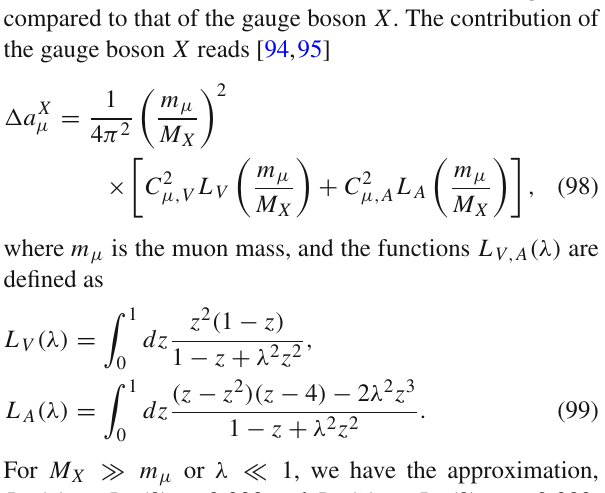
which is at 4 . 3 σ . In this model, the new contributions to the Table 2 The Z (cid:7) couplings to the SM fermions for the models generated from E 6 and SO ( 10 ) , with an overall e / cos θ W factored out and α LR (cid:21) anomalous magnetic moment of the muon are generated by 1 . one-loopdiagramsmediatedbythegaugeboson X ,theexotic , φ 0 } , as shown in Higgs h 2 , the neutral KK excitations { φ 0 1 n 2 n , φ 0 } are neutral components of the Fig. 3. (Note that, { φ 0 1 n 2 n KK doublets { φ 1 n , φ 2 n } , respectively.)